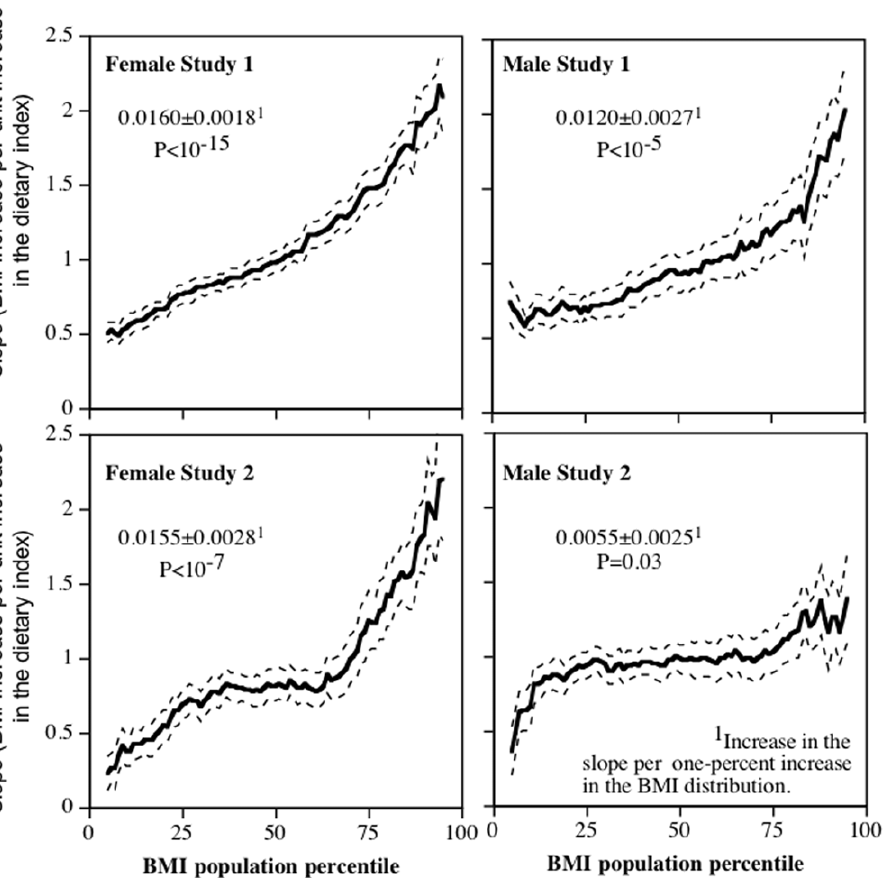
Figure 3. Percentile plot showing the slope for BMI vs. the dietary index (high-meat/low-fruit content, Y-axis) at each percentile of the BMI distribution (X-axis). The exact definitions of the dietary indices are described in the Methods Section. The dashed lines designate one standard error. Data adjusted for age, race, and education. Study 1 included additional adjustment for parental adiposity.